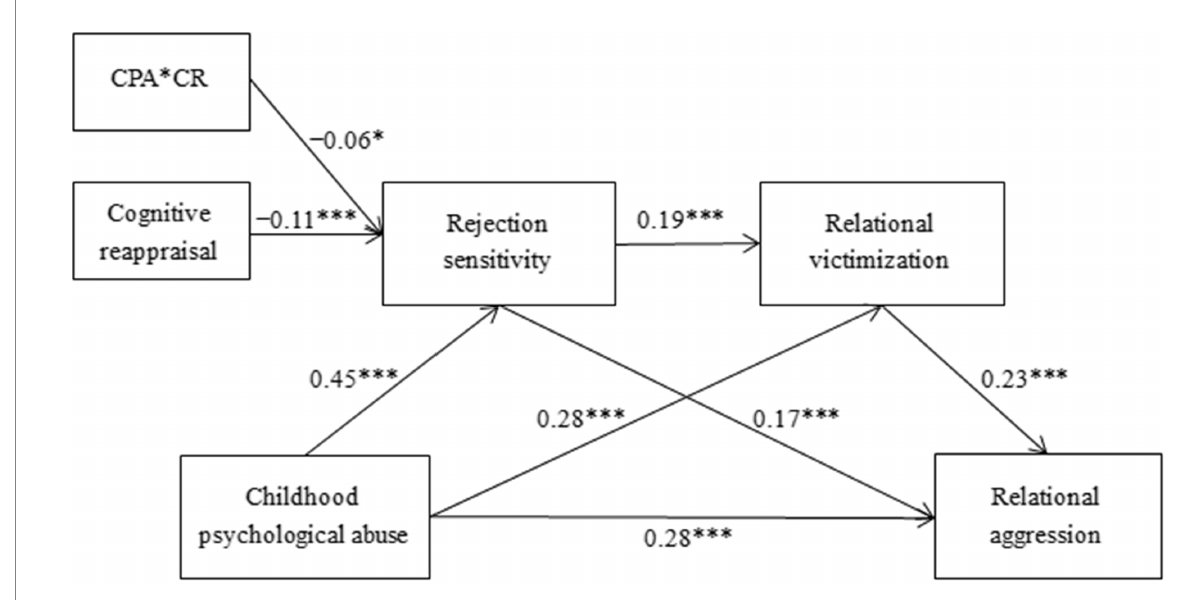
FIGURE 3 The moderated mediation model, gender and age are not represented in the model for concise purposes, * p < 0.05, *** p <